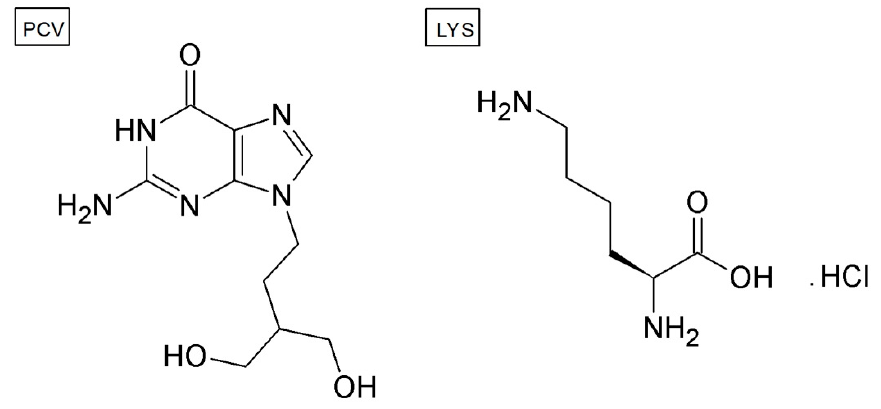
Figure 1. Molecular structure of penciclovir (PCV) and lysine (LYS).